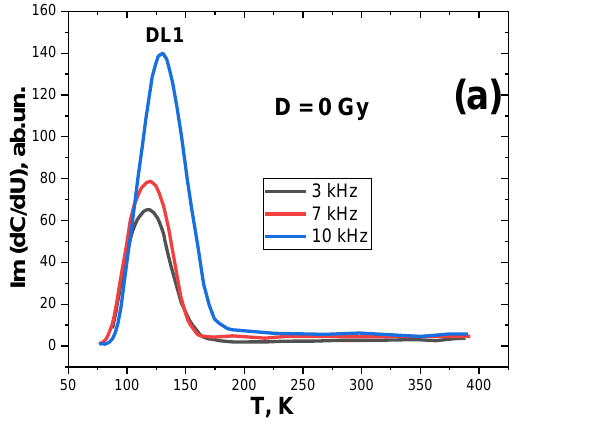
The temperature dependence of the imaginary component of the capacitance on the modulating voltage of the studied barrier structures is presented in Figure 5. According to this method, the activation energy of deep levels (DLs) in the BG of a semiconductor was determined [9]. As can be seen, before irradiation (Figure 5a), the near-surface layers of the barrier structures contained only one deep level (DL1), with an activation energy of Ev + 0.38 eV. This correlates well with the presented state density spectrum (Figure 4). Establishing conformity between the energy level in the BG and a certain type of de- fect is complicated. The depth of the energy level lies between the values corresponding to the K-center (Ev + 0.35 eV, Ev + 0.38 eV) and the interstitial silicon (Si I ) atom (Ev + 0.40 eV). It should be noted that the K-center is a complex of an interstitial oxygen atom and an interstitial carbon atom. K-centers can determine the lifetime of non-equilibrium carri- ers in p-type-conductivity silicon [45]. However, this defect is related to radiative creation [46], and its presence in the original sample of silicon is questionable.